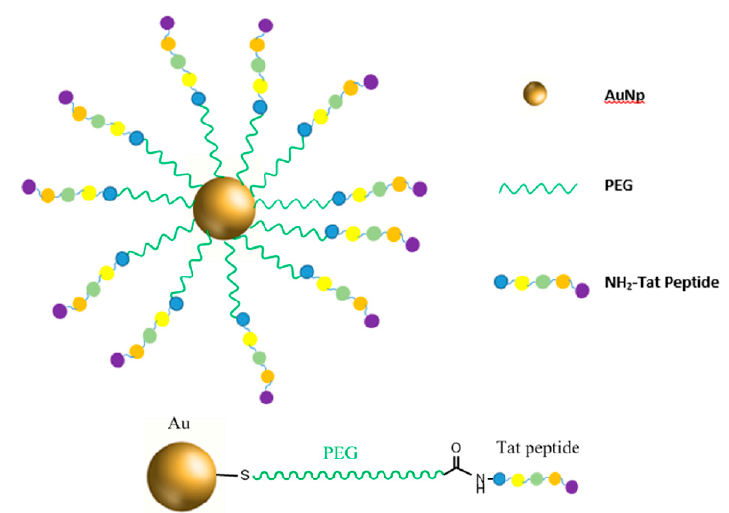
Figure 6. Targeted AuNp-PEG-Tat nanoparticle and chemical connectivity design.